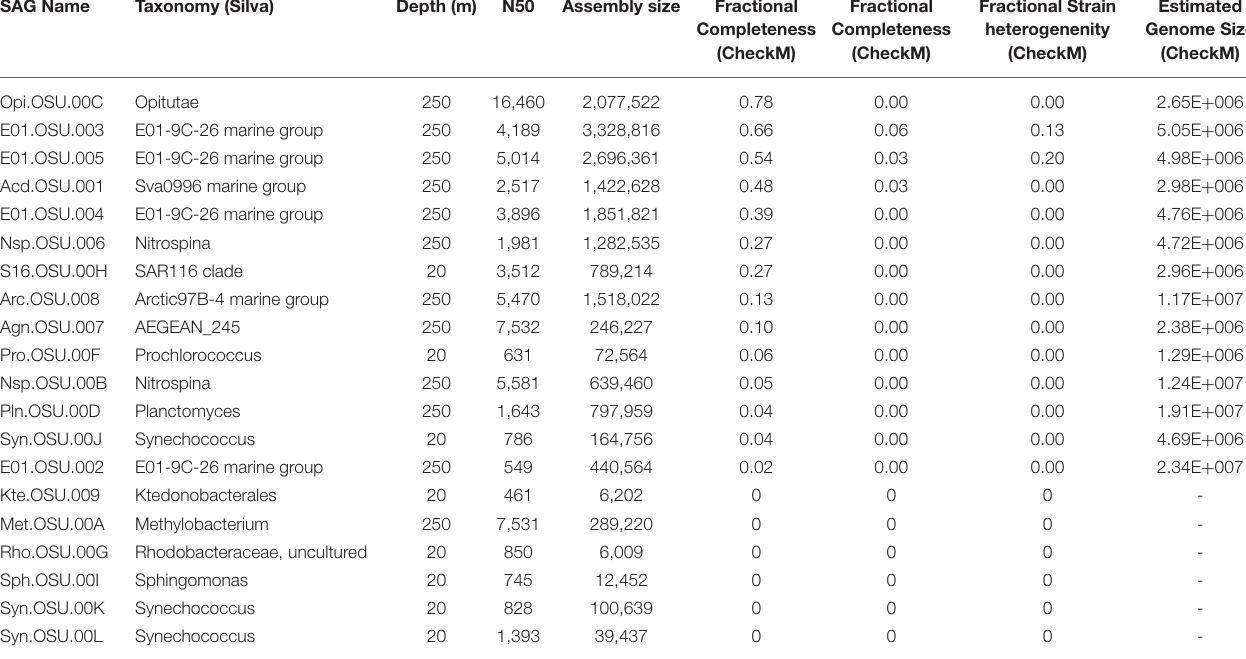
TABLE 1 | Assembly statistics and information for each SAG in this